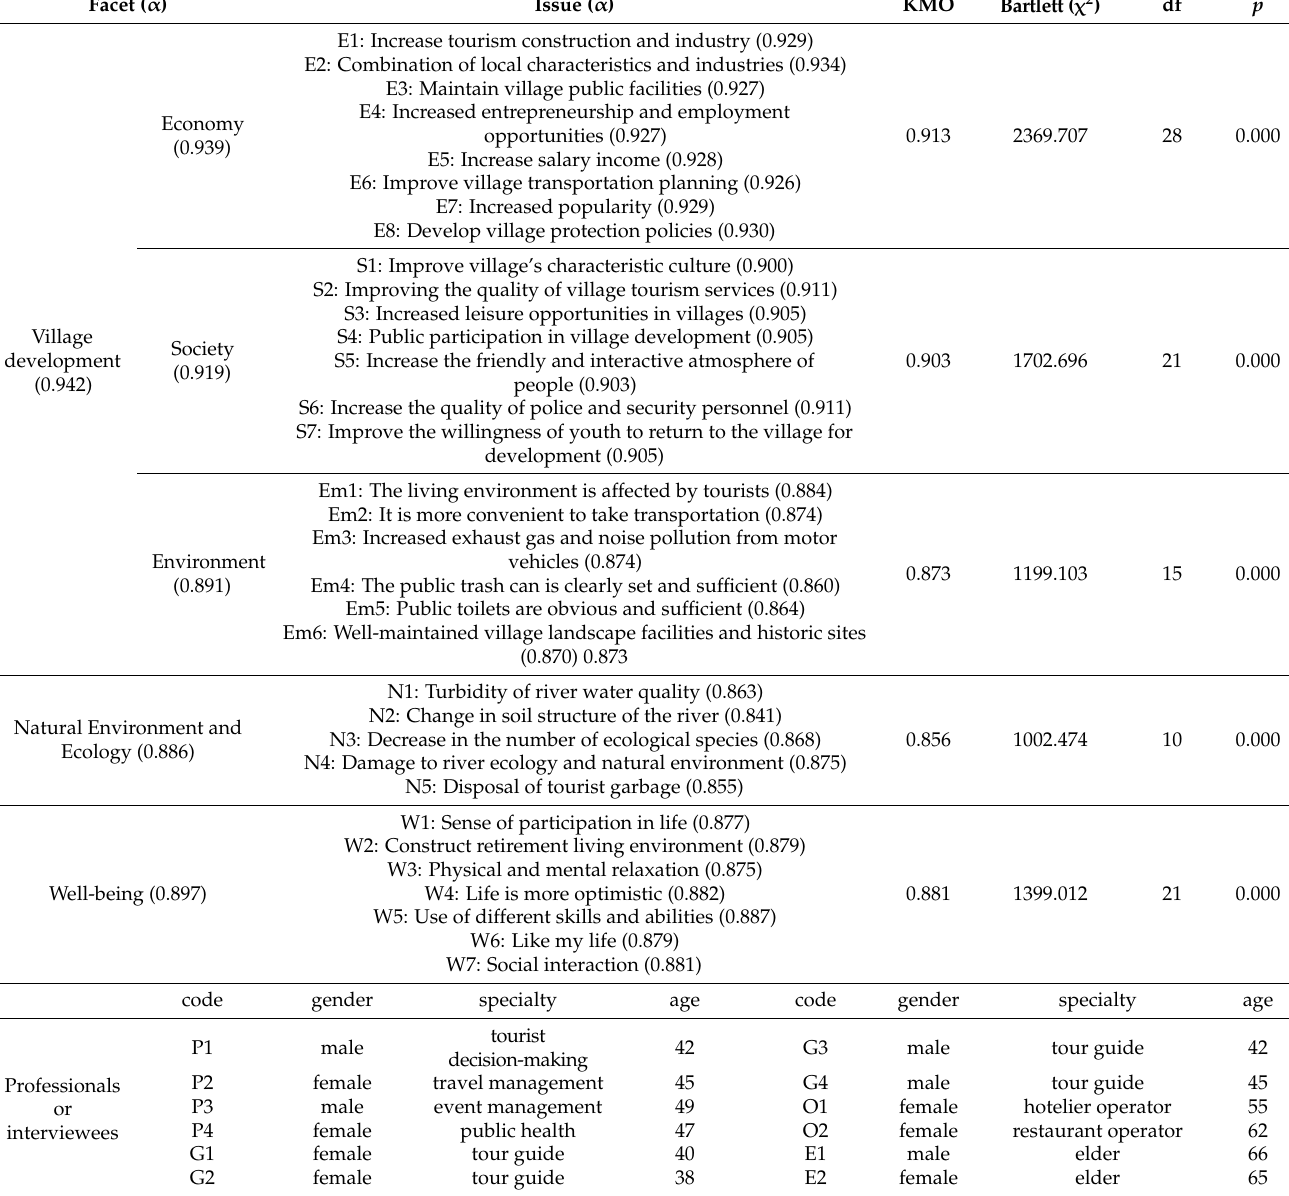
Table 1. Questionnaire and Respondent Background